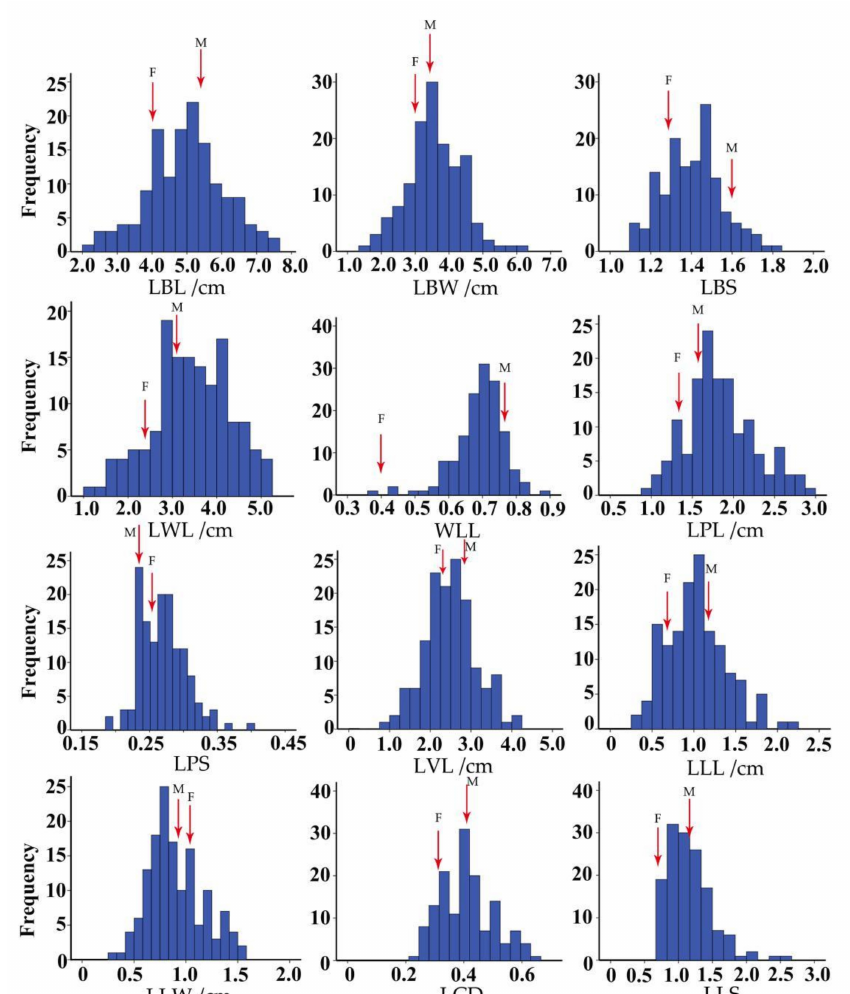
Figure 3. The frequency distribution for leaf traits in F 1 population derived from the cross I. The annotation of traits abbreviation is as shown in Table 1. Female parent value (F), male parent value